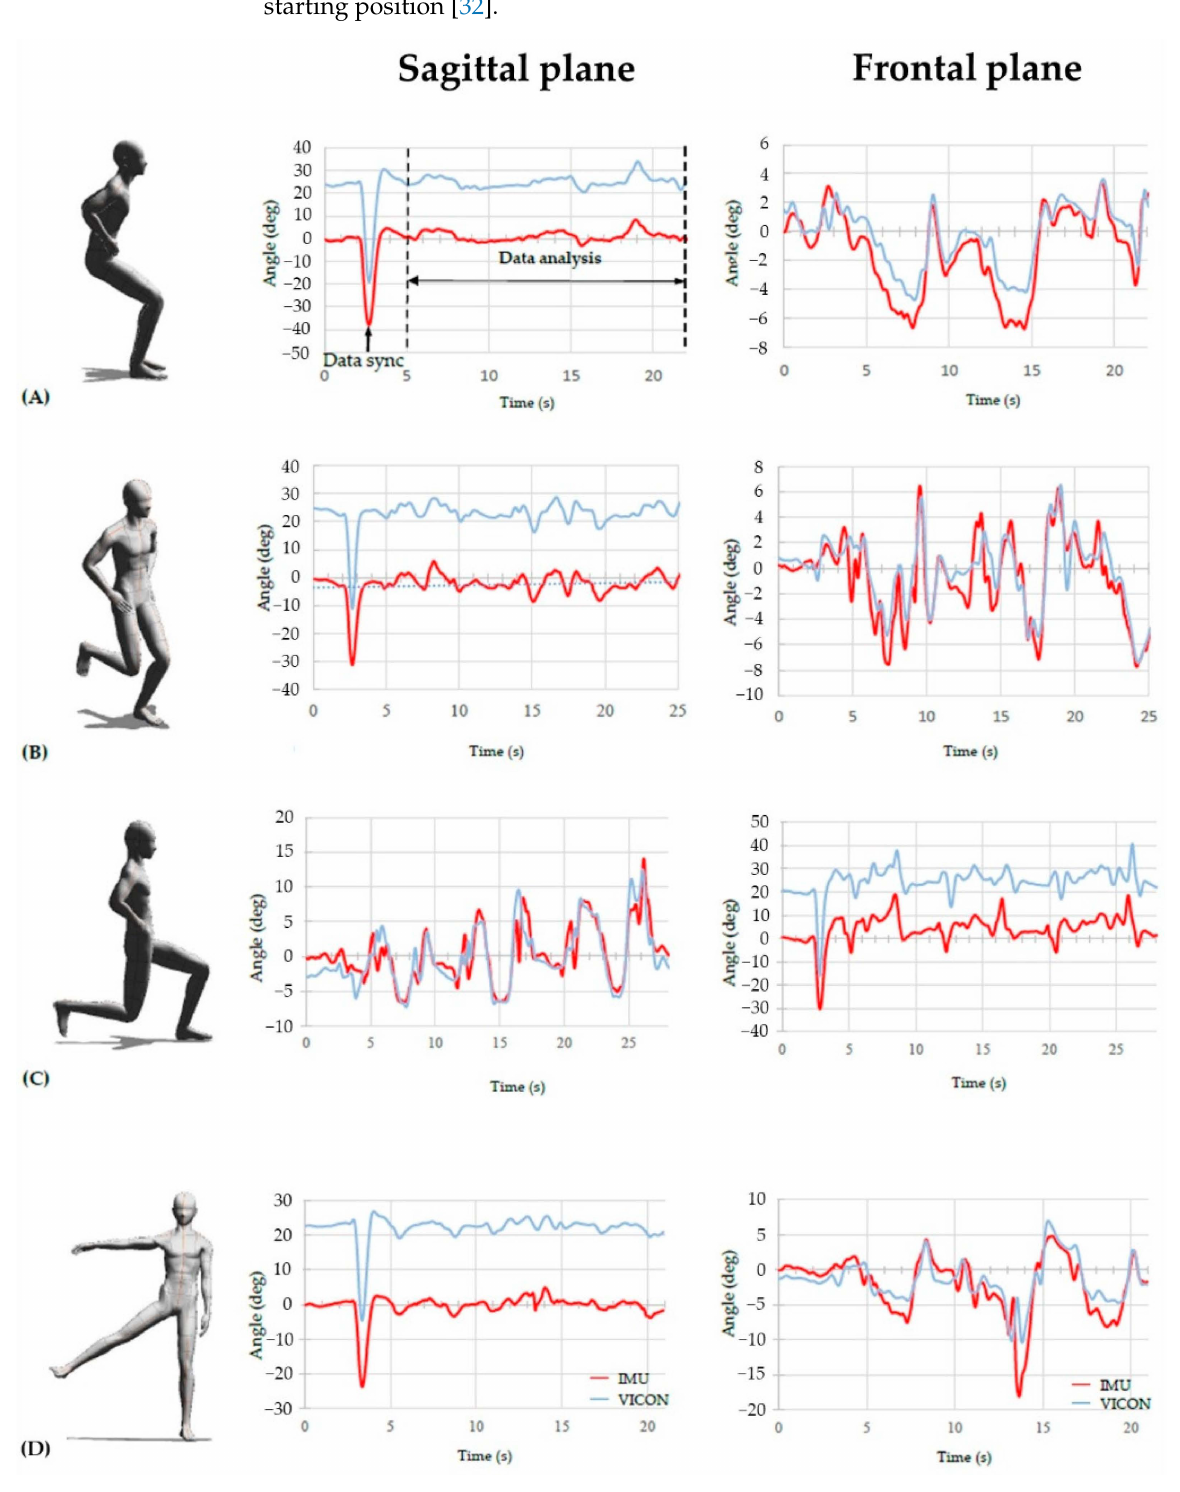
Figure 2. Comparisons of head angle between earbud-type IMU sensor and the 3D motion analysis system during each workout in sagittal plane and frontal plane. The two datasets were synchronised with each peak of rapid neck flexion (data sync.): ( A ) squat, ( B ) single-leg squat, ( C ) reverse lunge, and ( D ) standing hip